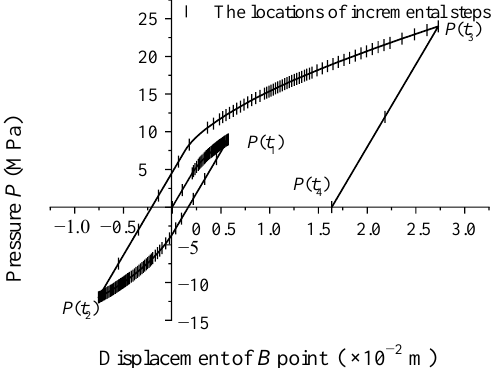
Figure 7. Location distribution of the adaptive load incremental steps in LIM. ( R C = 0.01). Different element types are considered to further confirm efficiency of the proposed adaptive method. The thick wall cylinder is divided by a four-node continuum plane stress element with five generalized inner forces (CPS4S5) [31]. A monotonic pressure loading path is loaded in the inner wall. This method still improves the computation effi- ciency sharply. More details can be found in Appendix A.